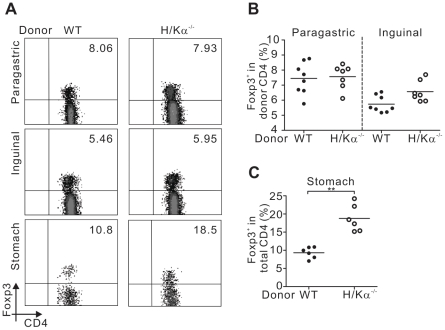
Mice with autoimmune gastritis have an increased level of Foxp3+ Treg cells in the stomach.Cells were harvested from (A, B) paragastric lymph node, inguinal lymph node and (A, C) stomach tissue for intracellular staining of Foxp3. The numbers indicate the percentages of Foxp3+ Treg cells in donor CD90.2+CD4+ T cells in paragastric and inguinal lymph nodes and Foxp3+ Treg cells in total CD4+ T cells in stomach tissue. Data pooled from three independent experiments. In (B) and (C), each circle represents the data from one mouse. Mann-Whitney U test was used; bars, mean, and **, P<0.01.